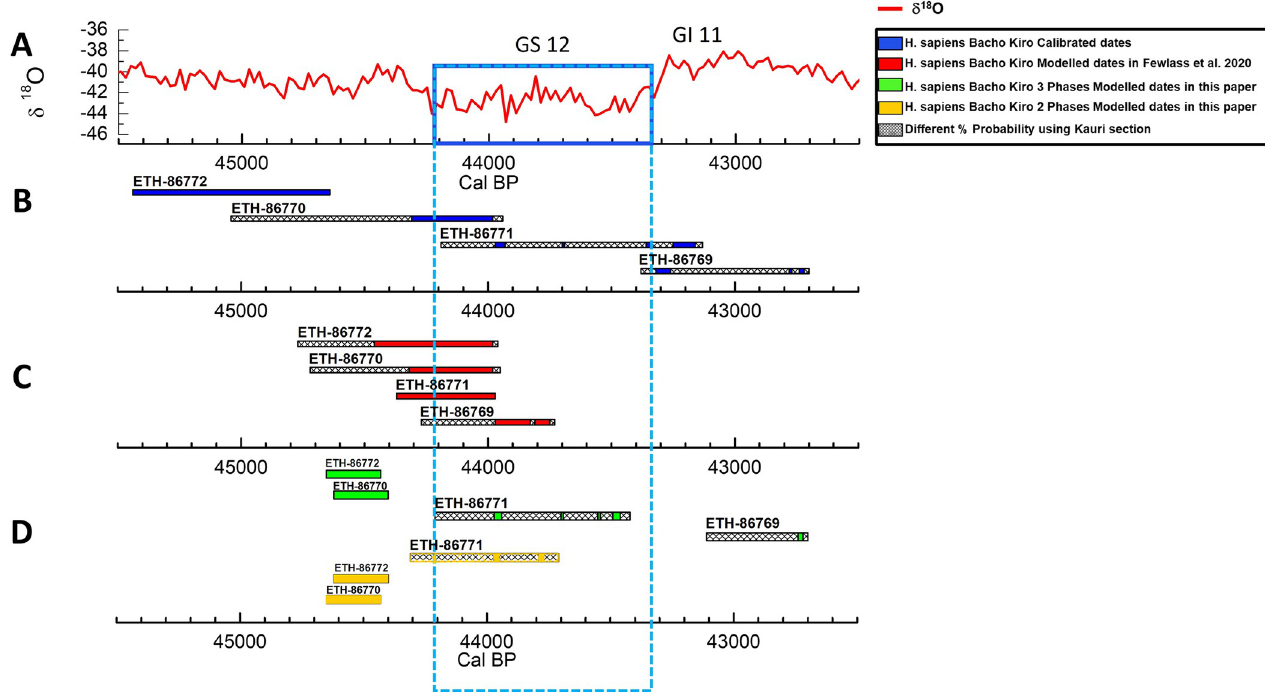
Fig 2. Unmodelled vs Modelled of the direct dates of Bacho Kiro Homo sapiens . A) the NGRIP δ 18 O curve spanning 45,500 to 42,500 cal BP. B) the calibrated ranges of the 4 Bacho Kiro Homo sapiens directly dated. C) the calibrated ranges obtained using OxCal model in [35] of the 4 Bacho Kiro Homo sapiens . D) the calibrated ranges of the 4 Bacho Kiro Homo sapiens were obtained using the 3 phases model (green) and 2 phases model (yellow). For all the bars, the hatched age ranges show differences using the IntCal20+Kauri curve. The blue rectangle highlights the GS12 cold climate phase.